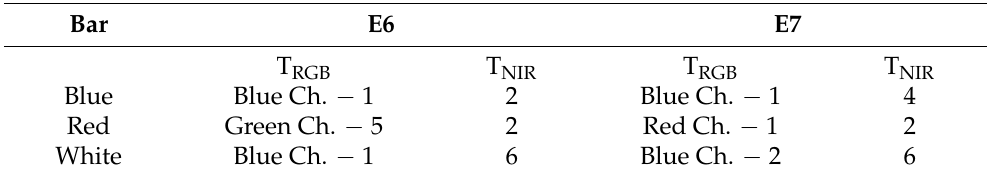
classesLuminance Red Ch. Green Ch. Blue Ch. o r o l C NIR T2 T3 T4 T5 T6 Number of segmentation Red Ch. Green Ch. Blue Ch. NIR